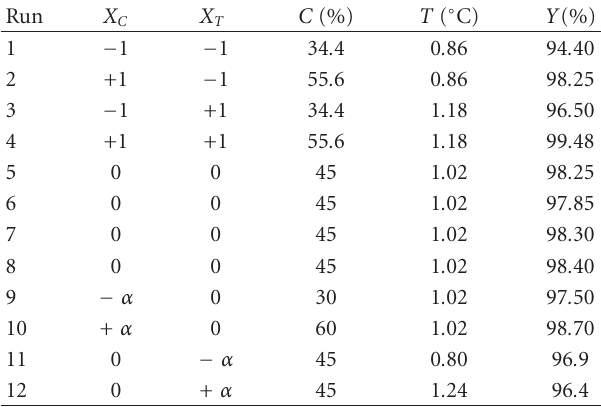
Table 2: Experimental matrix and experimental